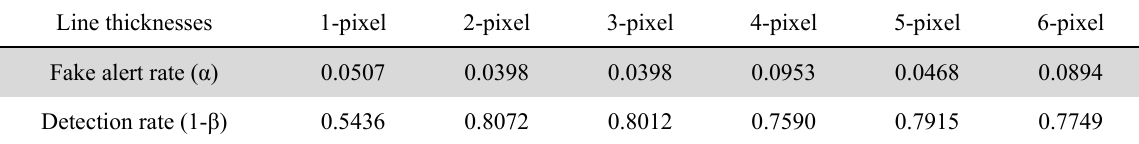
Performance indices of distortion flaw inspection by the proposed method for captured images using the concentric circles pattern with various line thicknesses